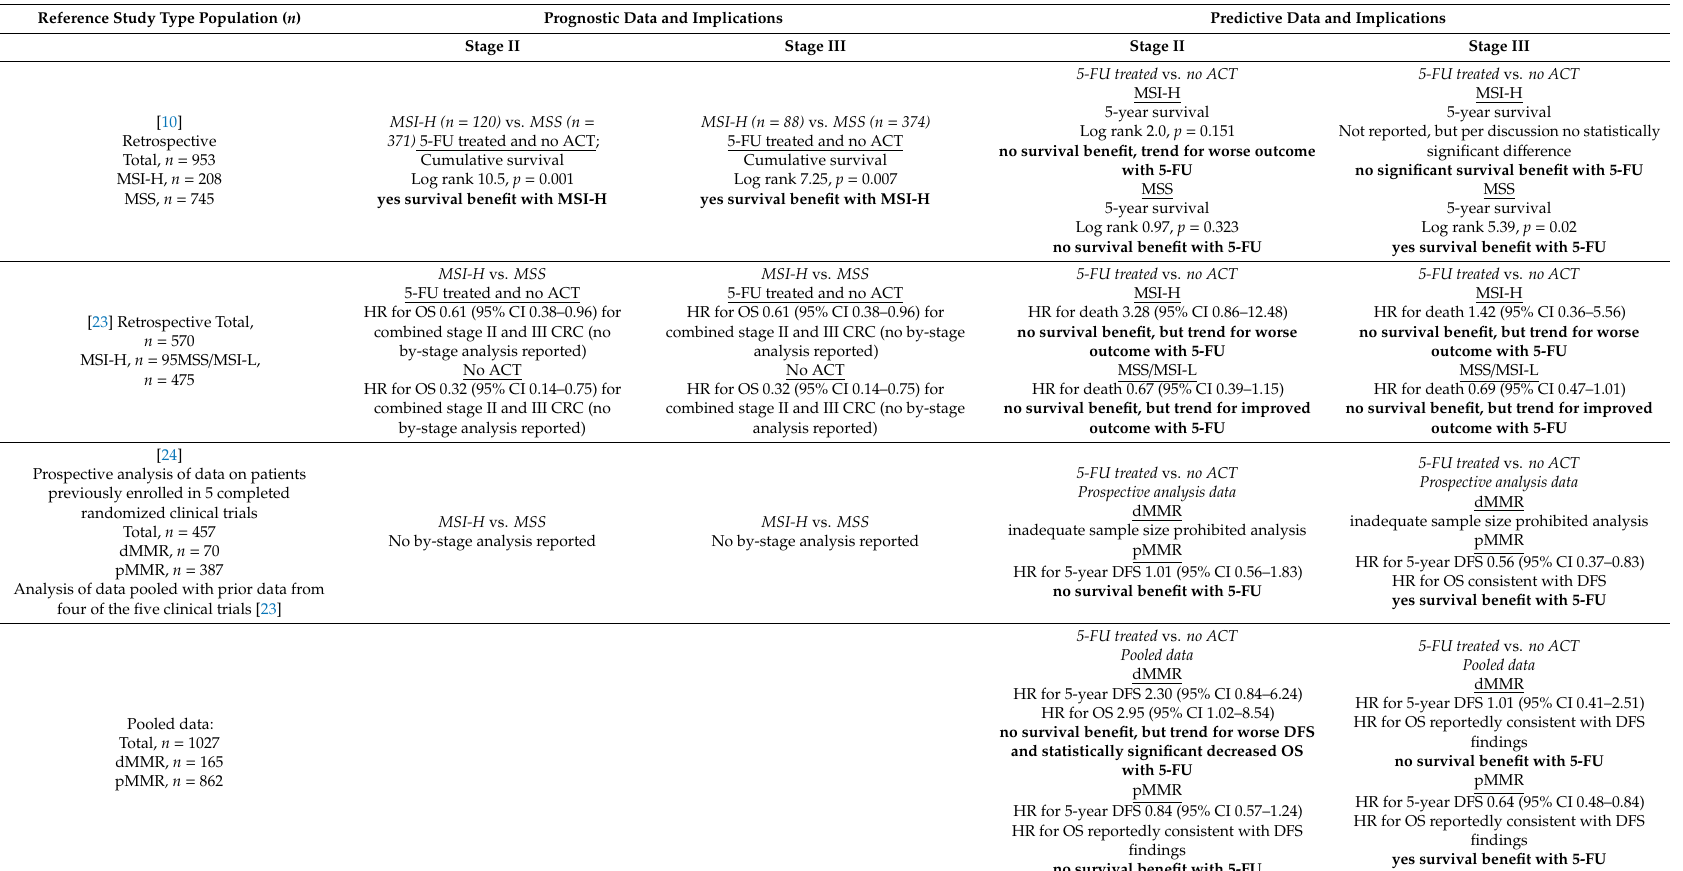
Table 3. Prognostic and Predictive Data Based on MSI Status in Stage II and III